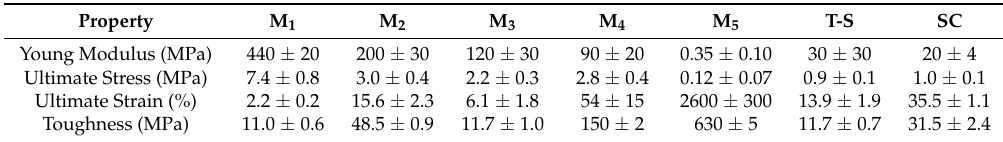
Figure 3. Stress-strain behavior of FCCs (M 1 –M 5 ), two stage polymer (T-S) and statistical copolymer (SC) at 25 °C (crosshead speed: 0.5 cm/min). For FCCs codes, see Figure 1. Table 1. Young’s modulus and ultimate properties of FCCs (M 1 –M 5 ), as well as T-S and SC materials at 25 °C and crosshead speed of 0.5 cm/min. For codes, see Figures 1 and 2.